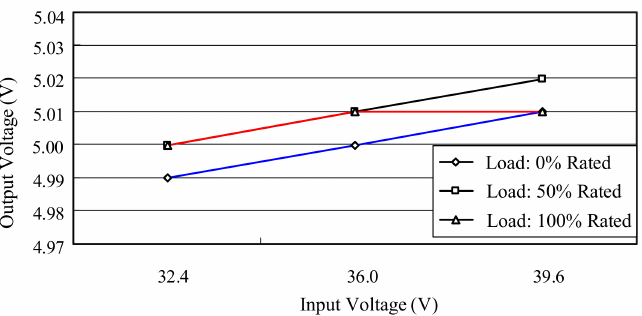
Figure 33. Curve of first secondary output voltage versus input voltage on condition that the main and second secondary outputs are located at rated load.